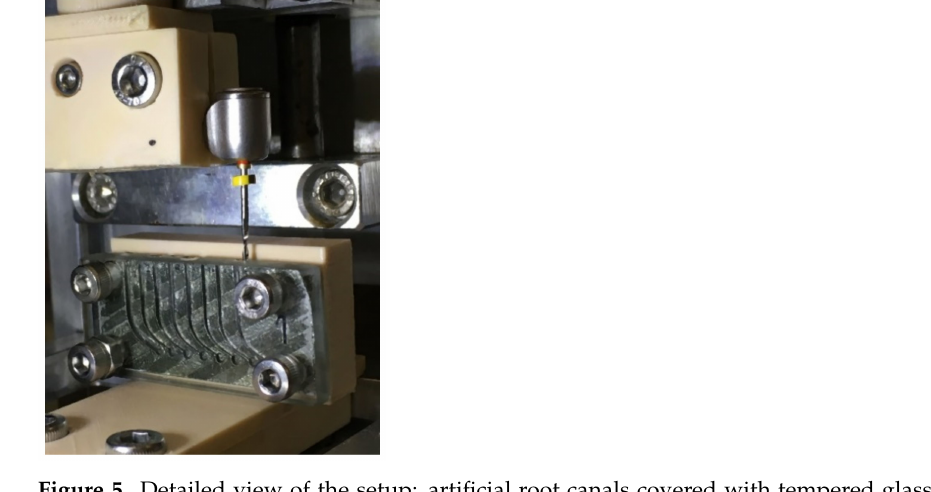
Figure 5. Detailed view of the setup: artificial root canals covered with tempered glass with an inserted